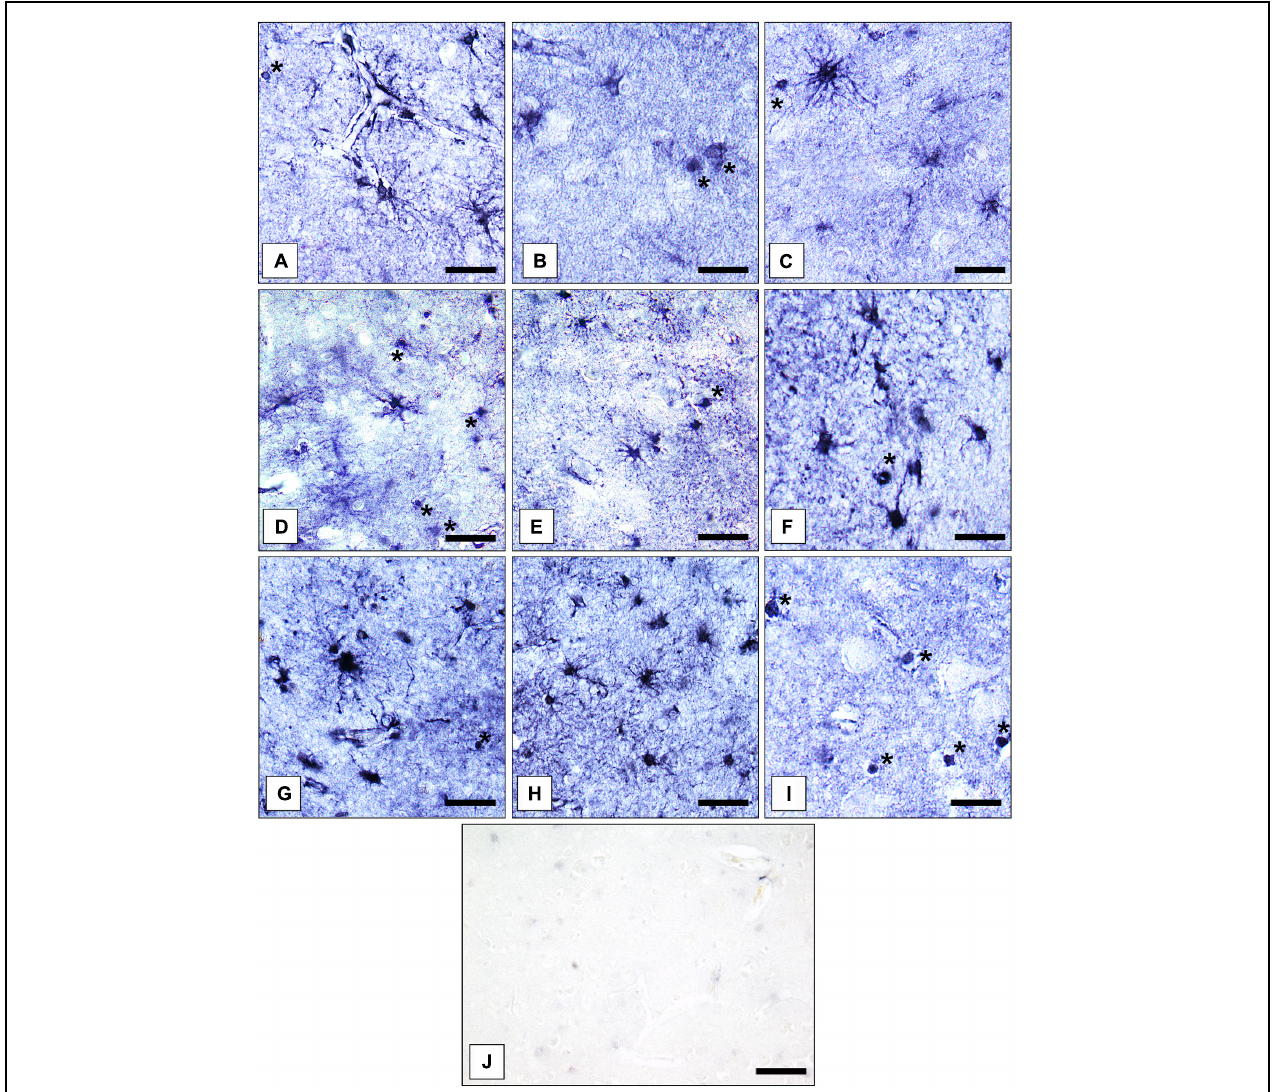
FIGURE 1 | Immunolocalization of GS in cortical and subcortical human brain glial cells in MDD, BD, and controls. (A) GS-immunoreactive ACs and OLs (asterisk) in the pACC (control case). Bar = 20 μ m. (B) GS-immunoreactive ACs and OLs (asterisks) in the pACC (MDD subject). Bar = 20 μ m. (C) GS-immunoreactive ACs and OLs (asterisk) in the pACC (BD subject). Bar = 20 μ m. (D) GS-immunoreactive ACs and OLs (asterisks) in the sACC (control case). Bar = 20 μ m. (E) GS-expressing ACs and OLs (asterisk) in the